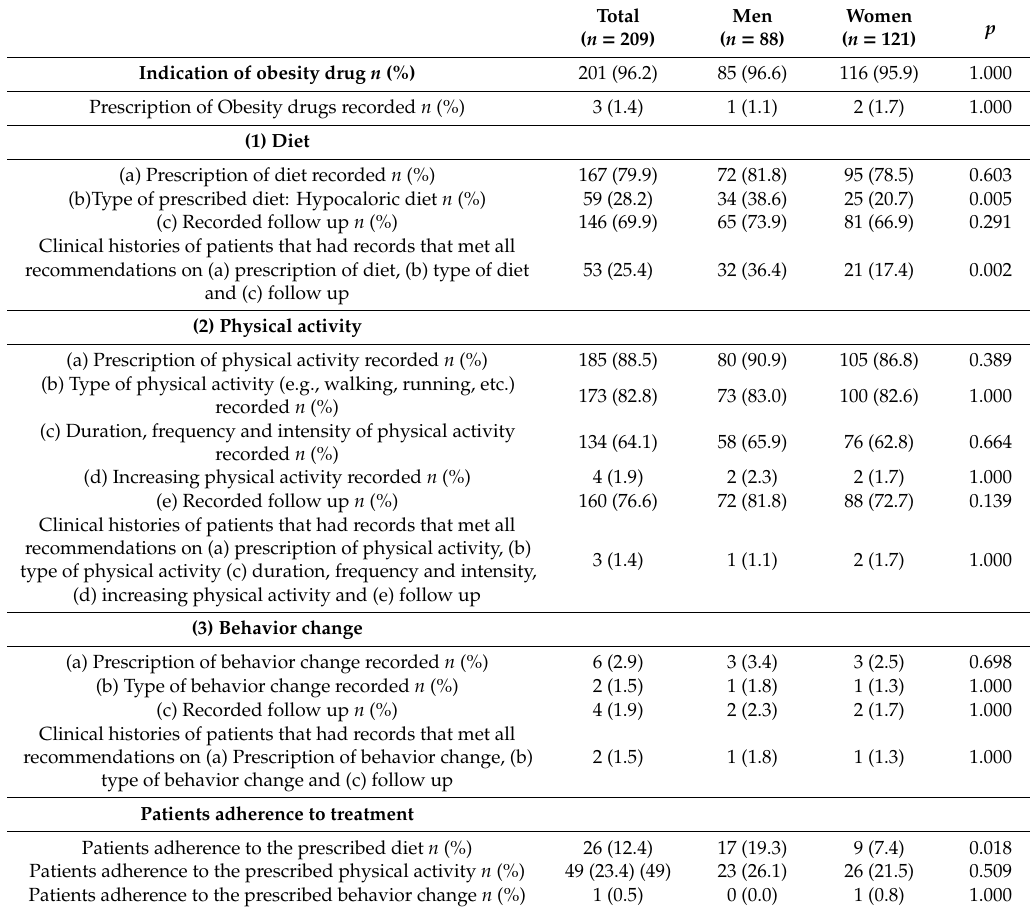
Table 3. Treatment recorded in clinical history in relation to the recommendations of obesity guidelines and patients’ adherence to